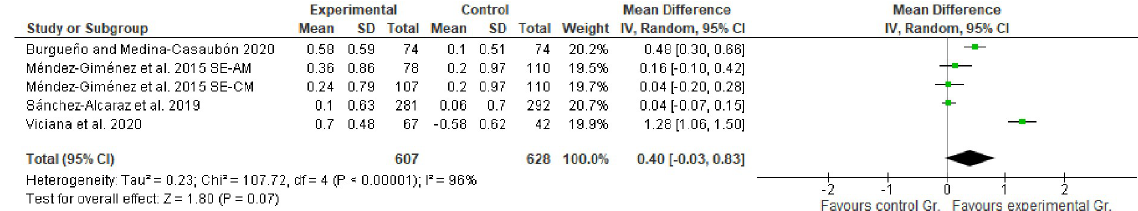
Fig 4. Results of the meta-analysis regarding the effects of interventions on the respect for rules and referees.